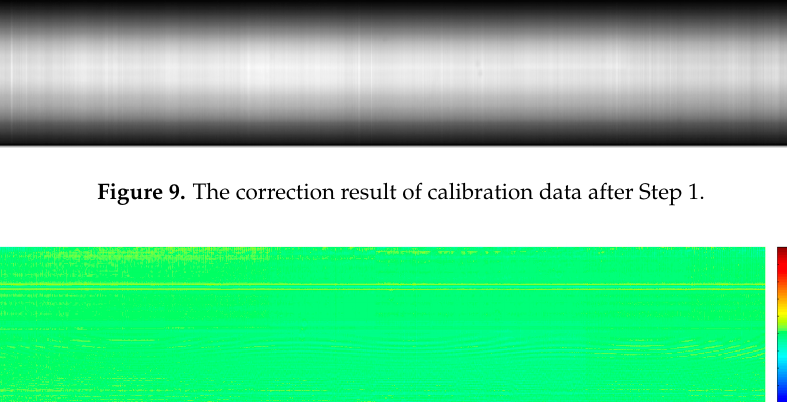
Figure 10. The fringe amplitude image after Step 1. Remote Sens. 2018 , 10 , 79